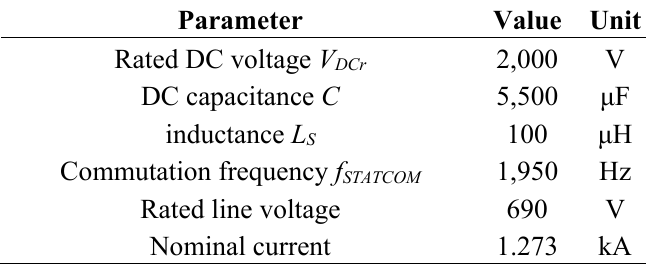
Table A5. STATCOM ratings.